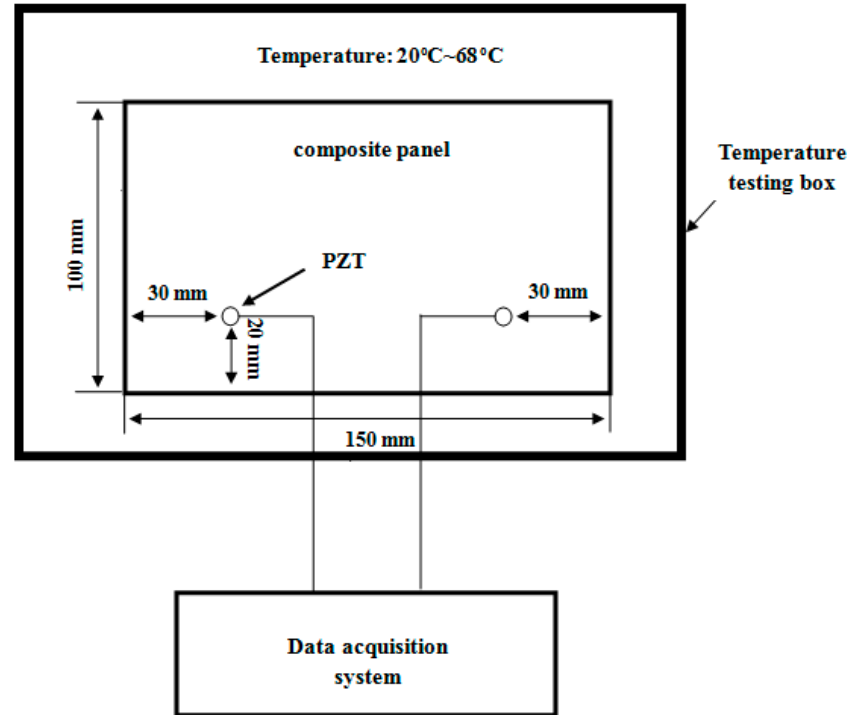
Figure 2. The schematic diagram of the PZT positions on the specimen used for temperature compensation validation without damage.